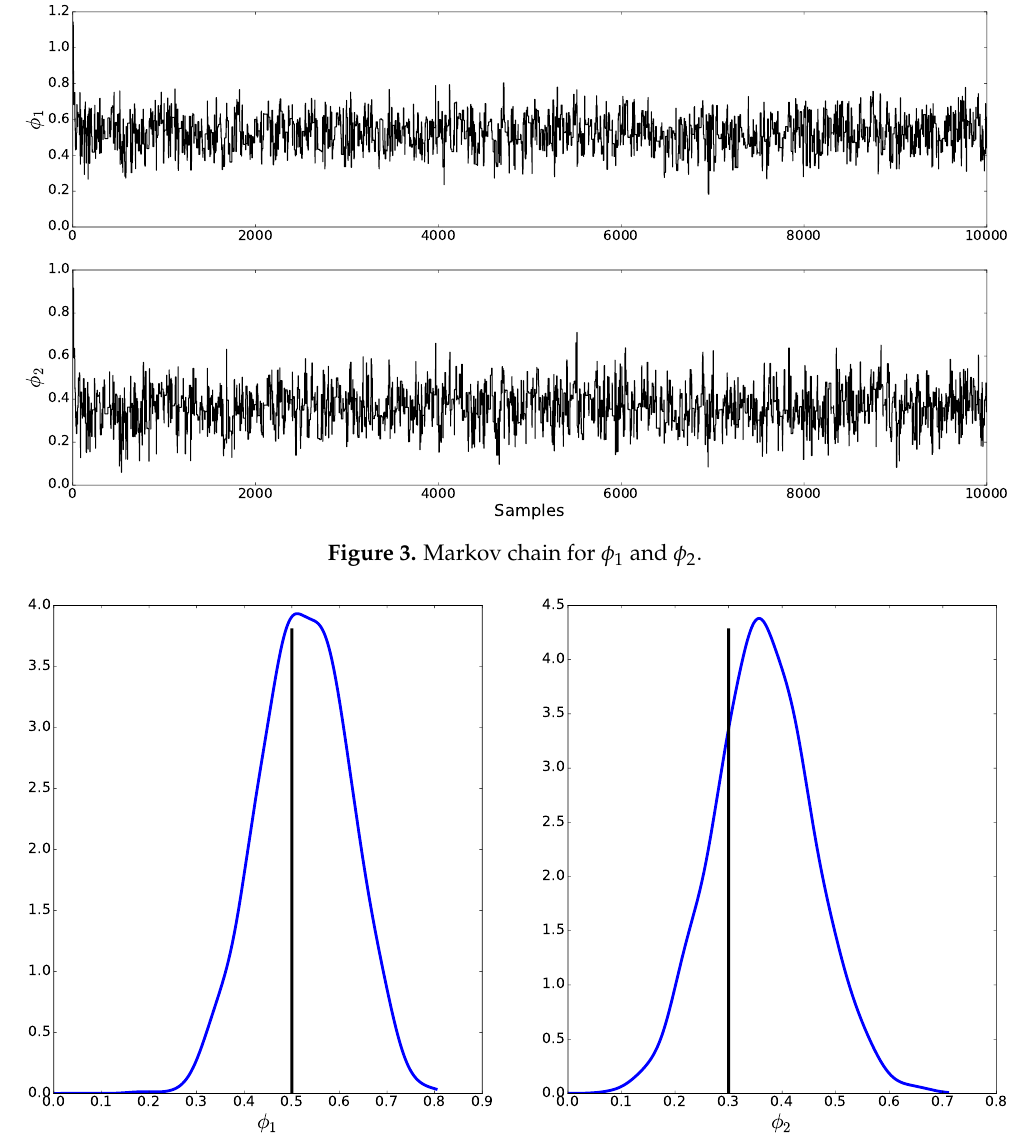
Figure 4. Kernel density estimation for the marginal posteriors of φ 1 and φ 2 . Vertical axes show probability density. Vertical bars show true simulated